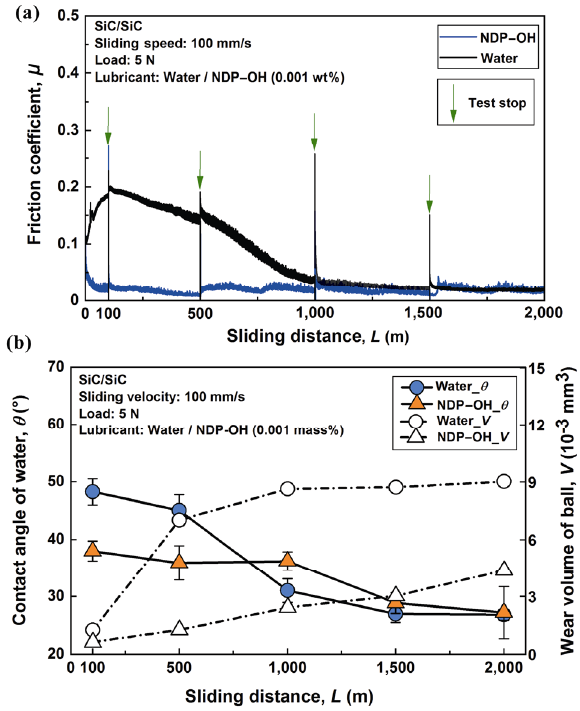
Fig. 6 Tribological performances of 2,000 m-sliding in NDP– OH (0.001 wt%) and pure water. Sliding speed and applied normal load are 100 mm/s and 5 N, respectively. Tests temporarily stopped at 100, 500, 1,000, 1,500, and 2,000 m, and properties are measured: (a) Friction evolution; (b) change in contact angle of water on wear surface of SiC ball (solid line) and tendency of wear amount in ball (dashed